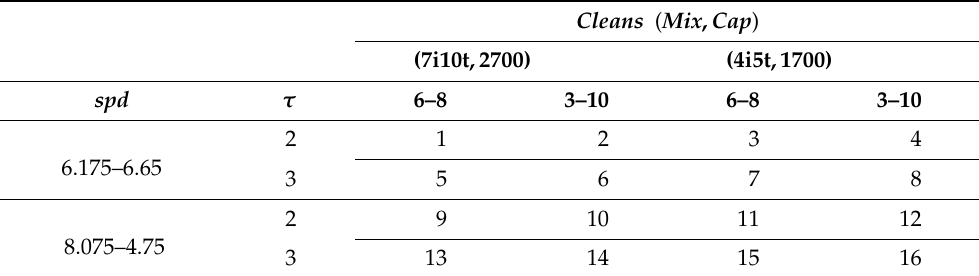
Table 8. Instance numbers as a function of parameters spd , τ , mix , cap and clean .